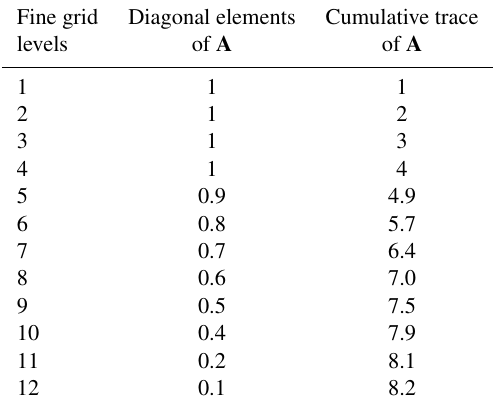
Table 1. A simple example for demonstrating the averaging kernel matrix’s role in finding the coarse grid which resembles the typical structure of a lidar temperature retrieval averaging kernel. The first column is the retrieval level which is typically in units of altitude for lidar OEM retrievals. The second column is the elements along the diagonal of the averaging kernel matrix A . The third column is the cumulative trace of A , where the last value determines the number of degrees of freedom per grid point for the coarse grid using Eq. (12).